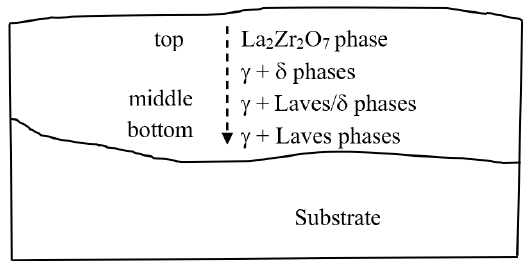
Figure 4. Schematic diagram of phase distribution in different areas of the laser modified layer.